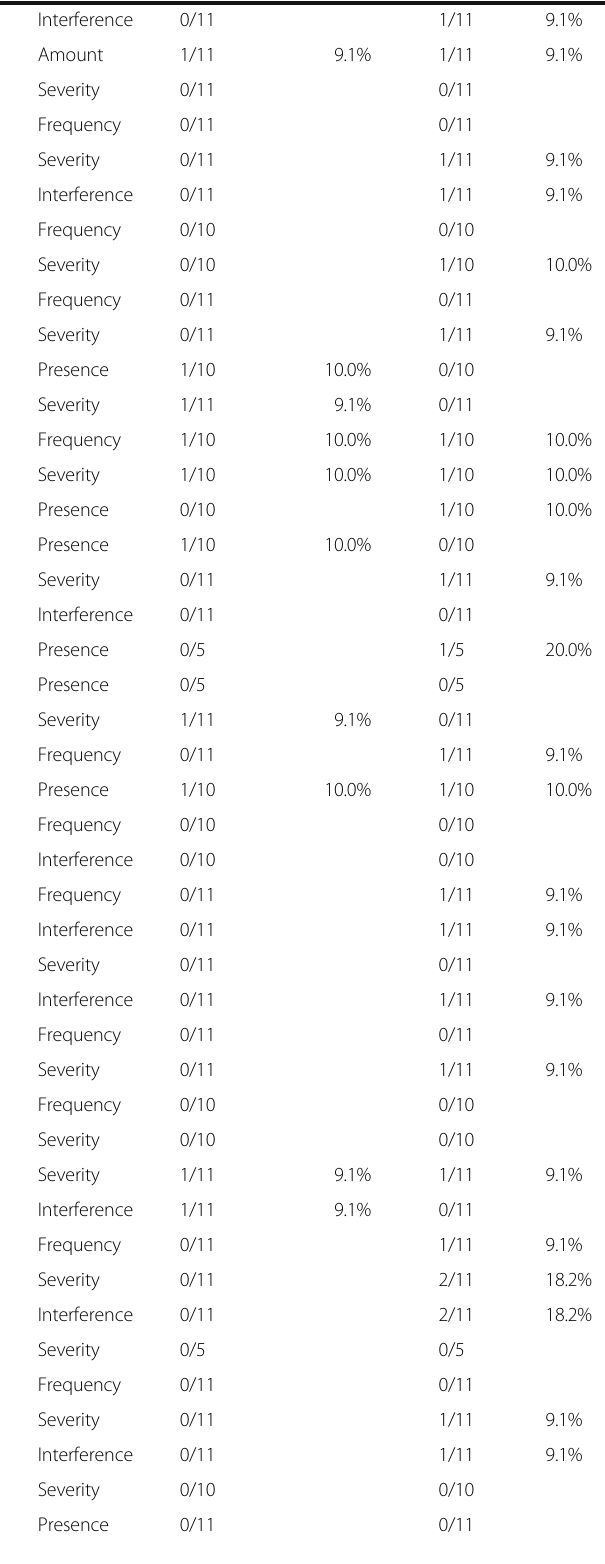
Table 2 Proportion of patients who evaluated items as “ difficult to understand ” or “ difficult to answer ”